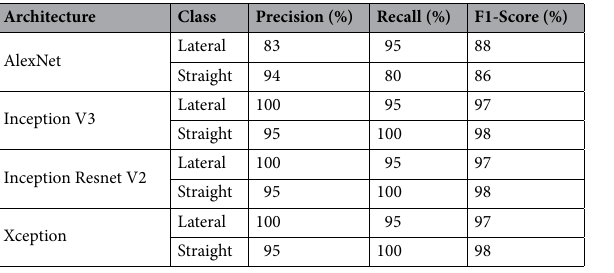
Table 3. The average precision, recall, and f1-scores across ten runs for the lateral and straight backlifts for each